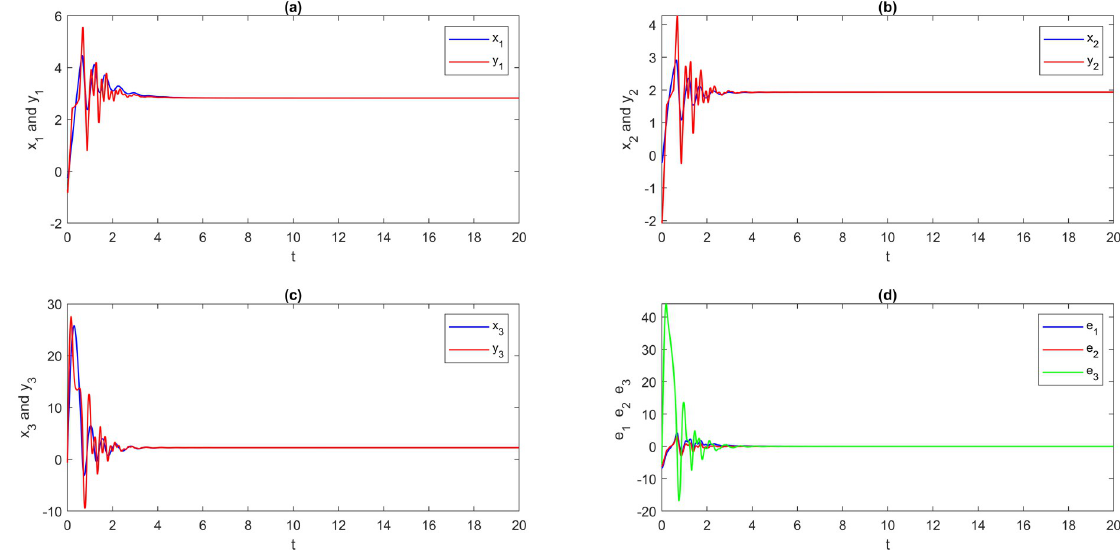
Fig 5. Multi time-varying delay of multi-FONNSMD synchronization with controller activation. (a) x 1 versus y 1 , (b) x 2 versus y 2 , (c) x 3 versus y 3 , and (d) Synchronization